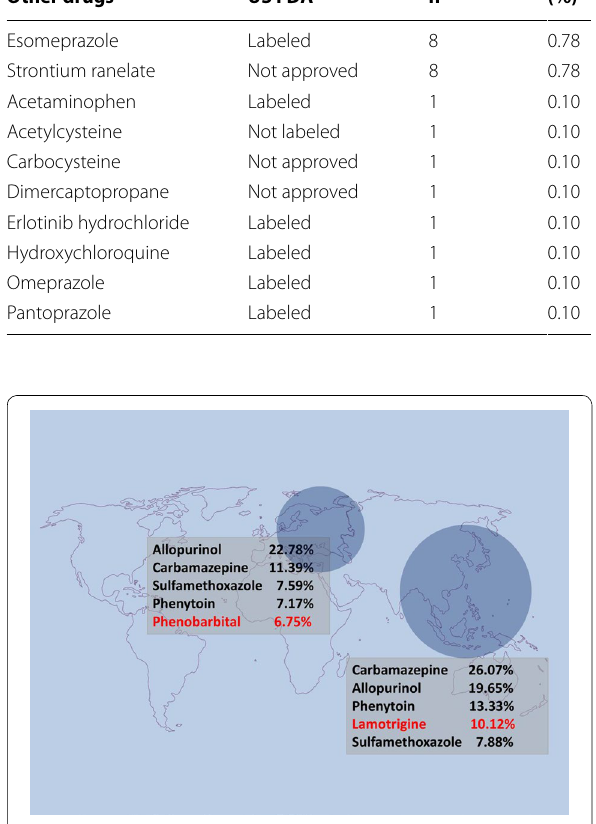
Fig. 1 Differences between Asian countries and European